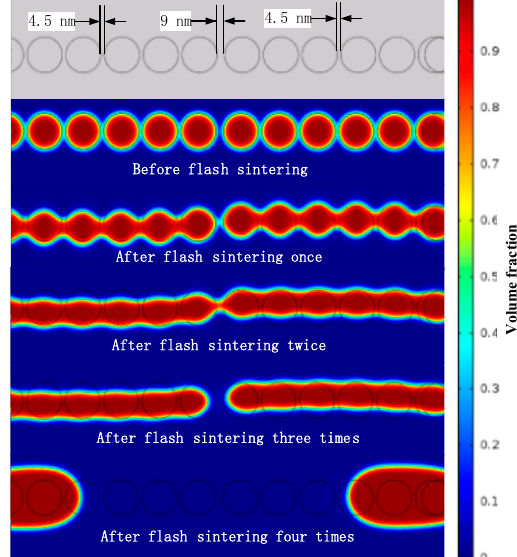
optimally sintered silver film; and ( c ) the damaged surface of an over-sintered silver film.